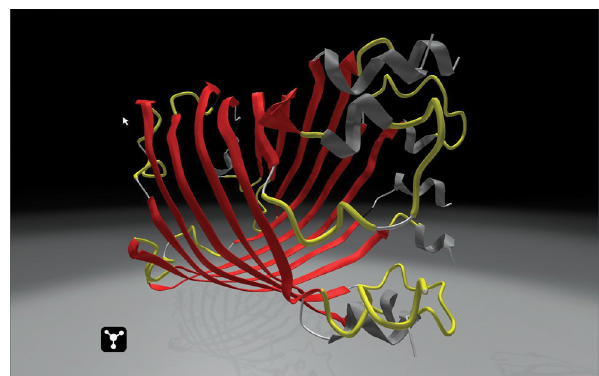
Figure 4: Three intertwined tube meshes representing the secondary structure of a membrane protein.